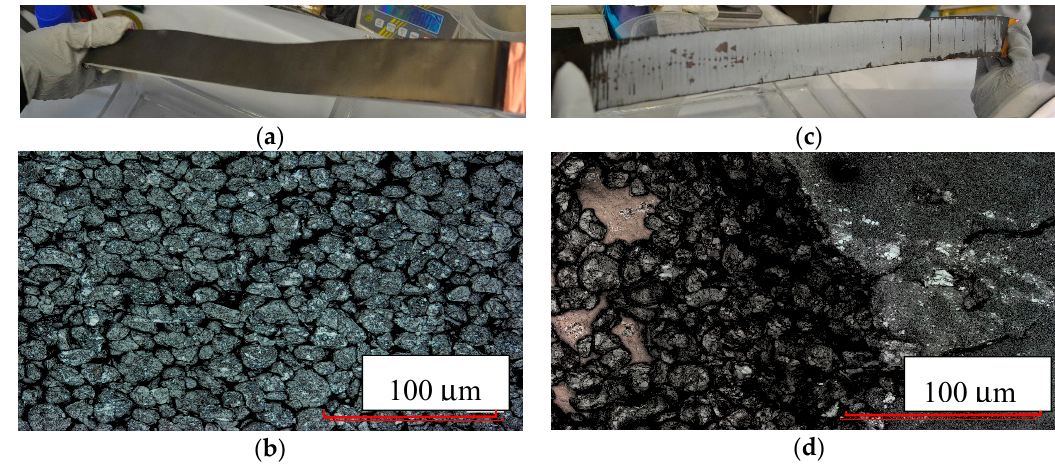
Figure A5. Visual inspection of the negative electrode after disassembling ( a ) the fresh cell and ( c ) the aged cell. Images taken with the laser microscope of the ( b ) fresh negative electrode and ( d ) the aged negative electrode. Methodology and complete post-mortem analysis can be found in [40].